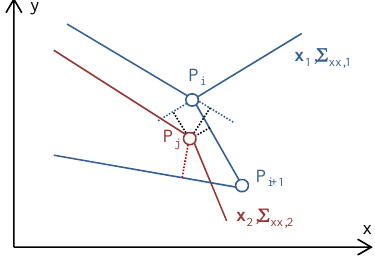
Figure 3. Example for several assignments for point P j